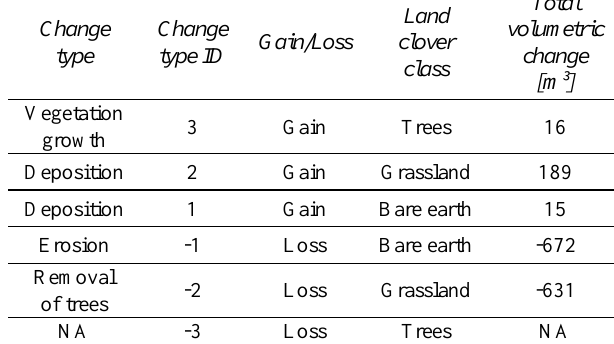
Table 1. Volumetric changes for different change types and land